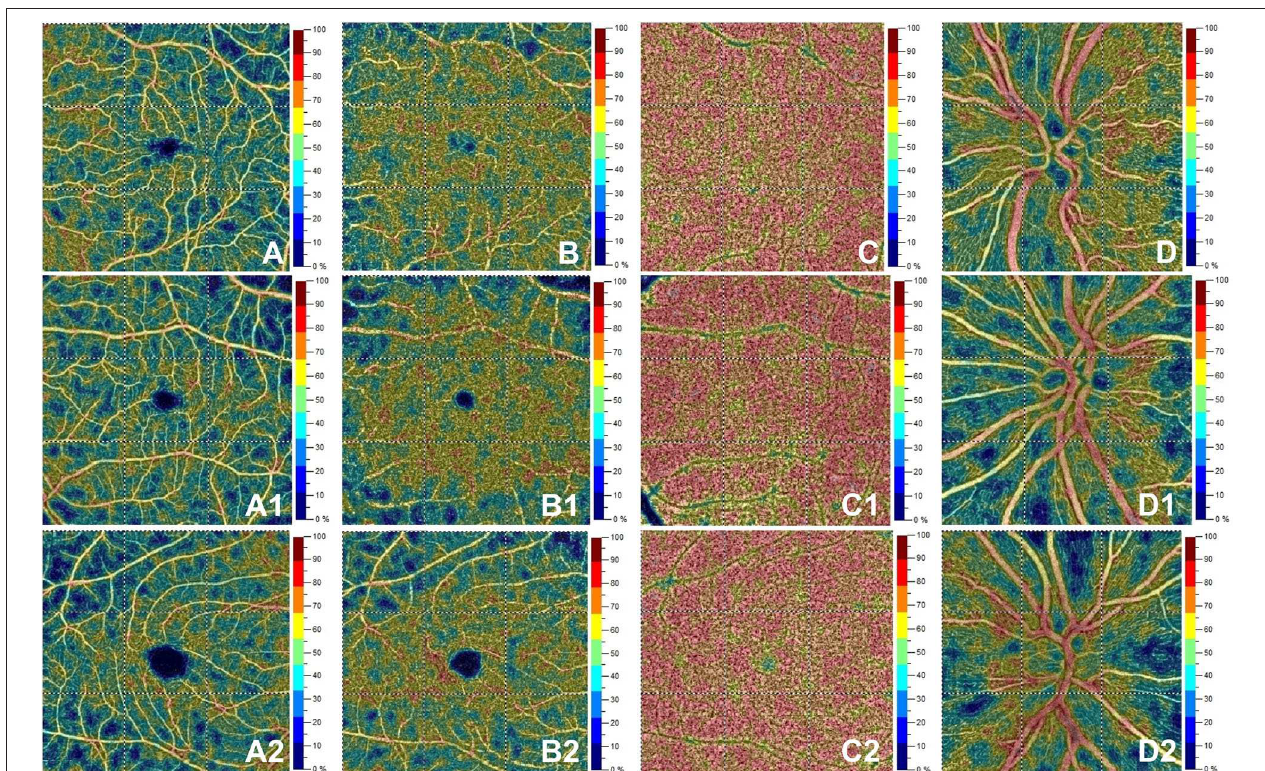
FIGURE 2 | Optical coherence tomography angiography (OCT-A) images from a healthy subject’ s left eye (male, 28 years) in the first row show normal vessel density in superficial capillary plexus (A) , deep capillary plexus (B) , choriocapillaris (C) and radial peripapillary capillary plexus (D) . The second row depicts OCTA features in the left eye for a patient (female, 28 years) with initial demyelinating event. OCTA reveals normal vessel density in superficial capillary plexus (A1) , deep capillary plexus (B1) , choriocapillaris (C1) with a decrease for vessel density in the radial peripapillary capillary plexus (D1) . The bottom row shows a patient’s right eye (male, 29 years) affected by relapsing-remitting multiple sclerosis. Here, vessel density is reduced in the superficial capillary plexus (A2) and radial peripapillary capillary plexus (D2) without vessel density changes in the deep capillary plexus (B2) and choriocapillaris (C2)